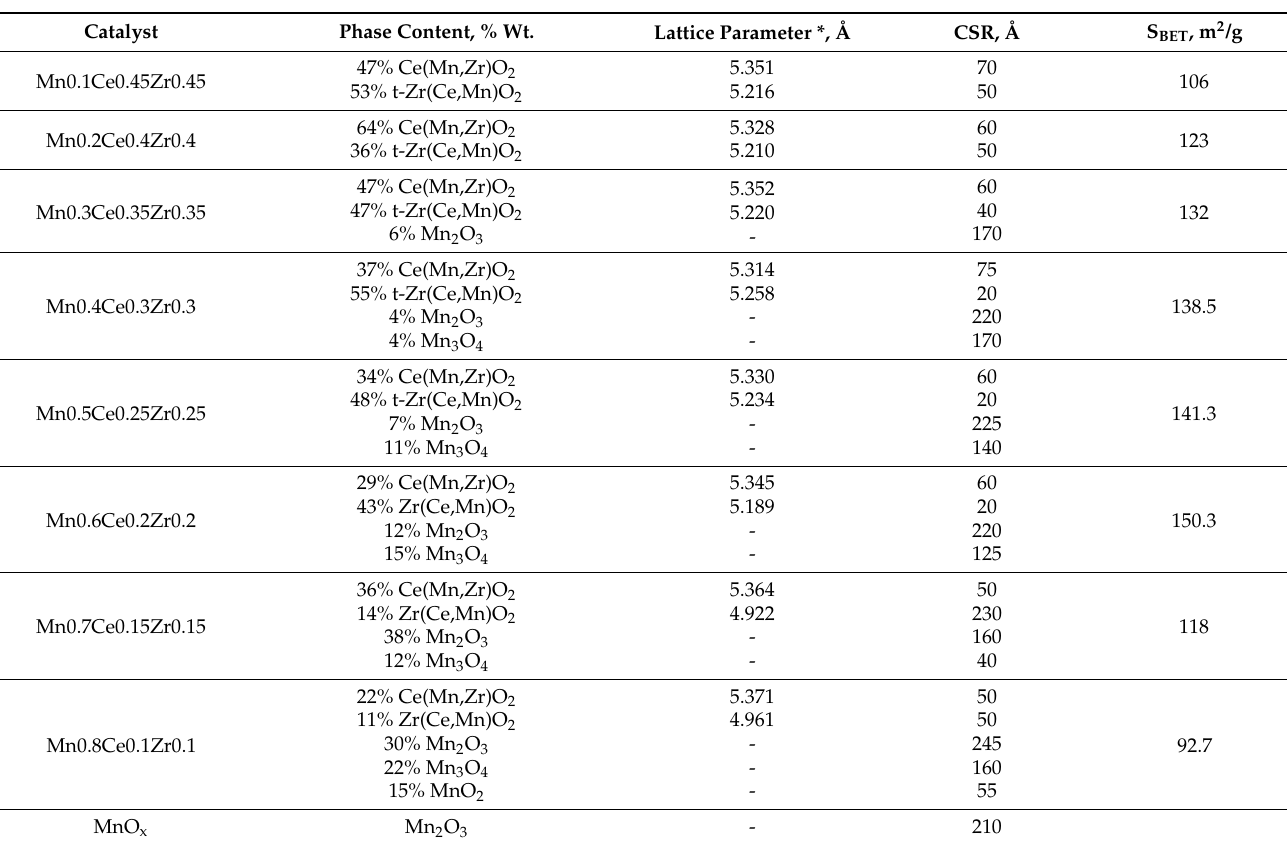
Table 3. Phase composition, lattice parameter of solid solution, CSR, and surface area for Mn(x)Zr(0.5 − x/2)Ce(0.5 − x/2)catalysts.